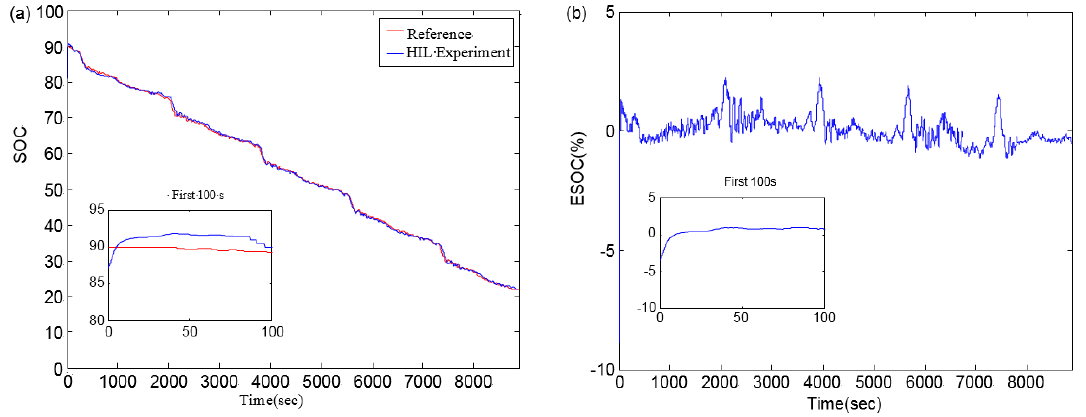
Figure 14. SOC estimation results: ( a ) SOC estimation; ( b ) the error of SOC estimation.